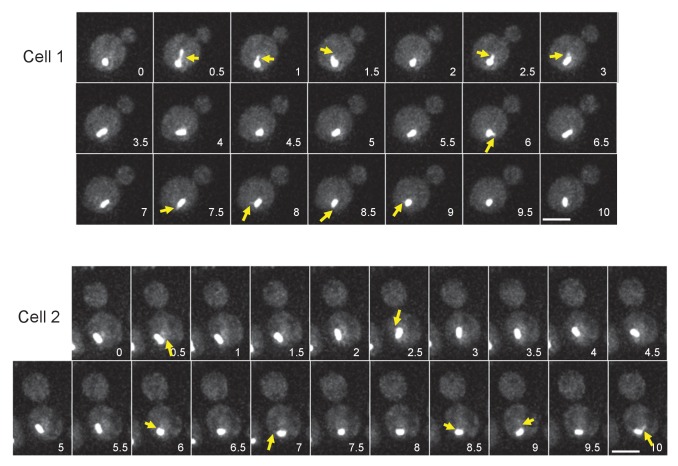
Time-lapse microscopy of GFP-TUB1 cells.Representative images of time-lapse microscopy in (D). GFP-TUB1 cells (HPH194) were grown in SD complete medium at 30°C. Consecutive sections were taken every 30 s. Yellow arrows point cMTs. Scale bar, 2 µm.